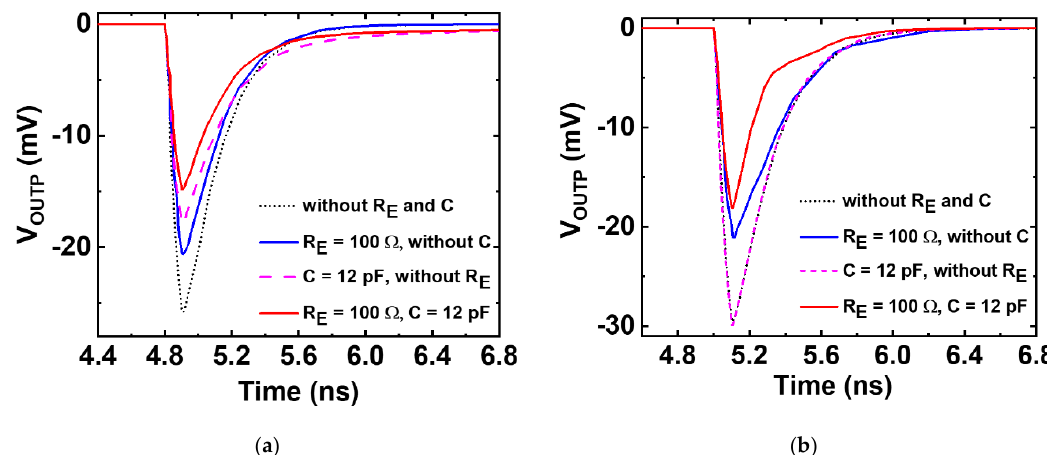
Figure 6. ( a ) Transient responses at the output terminal (Q 4 collector) of the differential pair when an excess current was injected in the output transistor Q 2 of the DC current mirrors of all four CML circuits in Figure 2; ( b ) Transient responses at the output terminal (Q 4 collector) when an excess current was injected in transistor Q 4 of the differential input pair of all four CML circuits in Figure 2.